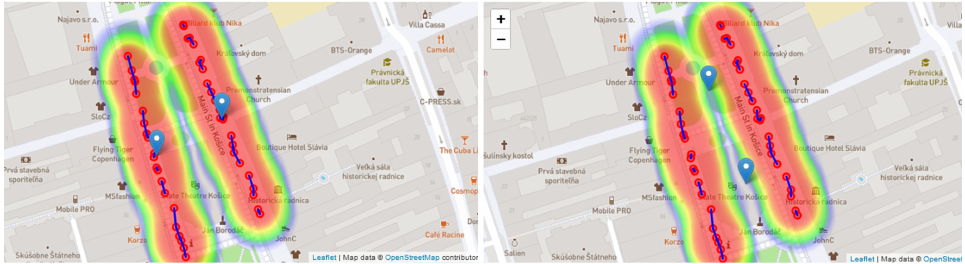
Figure 10. Analysis of irregular cluster shapes using DBSCAN ( left ) and K-means ( right